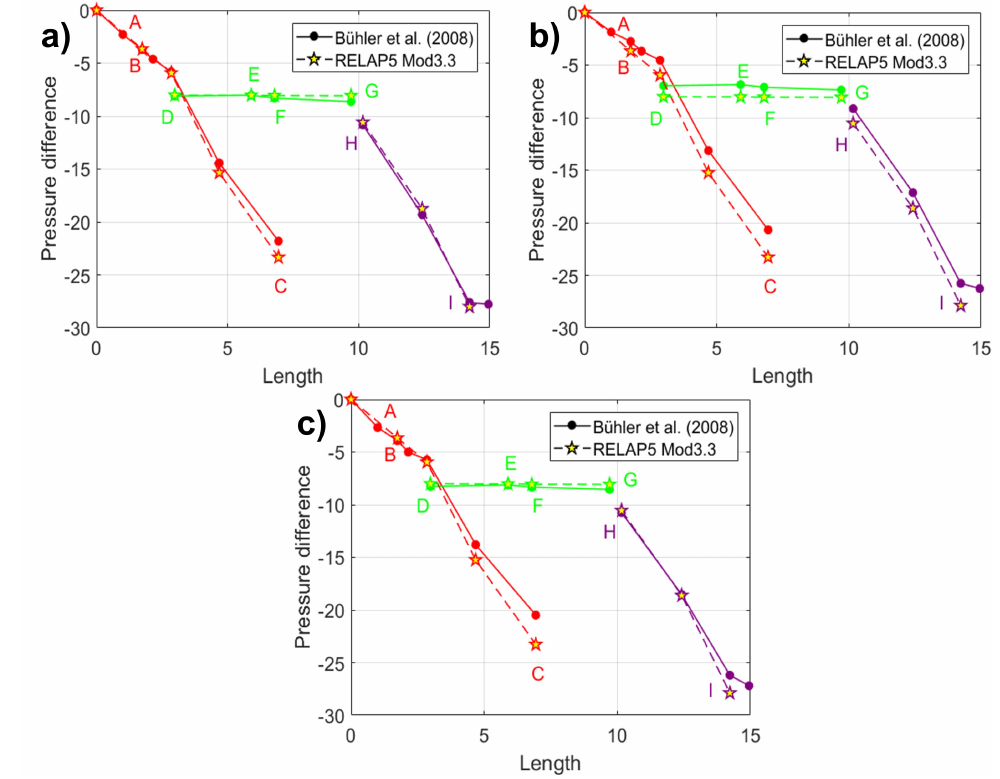
Figure 16. Nondimensional pressure drop versus scaled length. Comparison of results be- tween R5 and reference experiment. ( a ) Ha = 3000, Re = 3360. ( b ) Ha = 4000, Re = 1140. ( c ) Ha = 5000, Re =